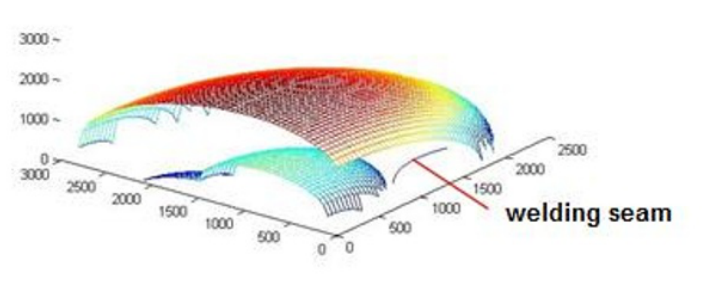
Fig. 12. The possible position of the weld relative to the working area of the robot, providing continuous welding.